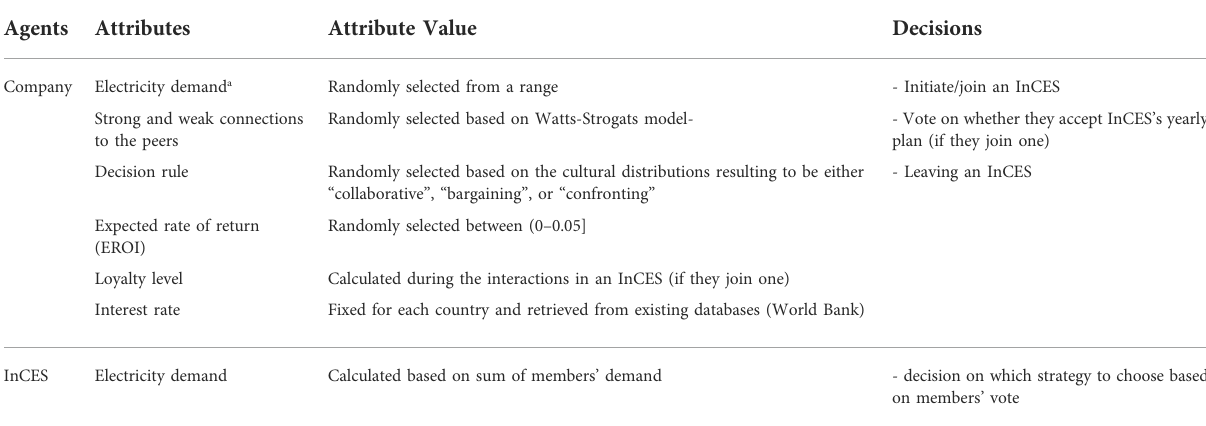
TABLE 2 Agents attributes in the model.